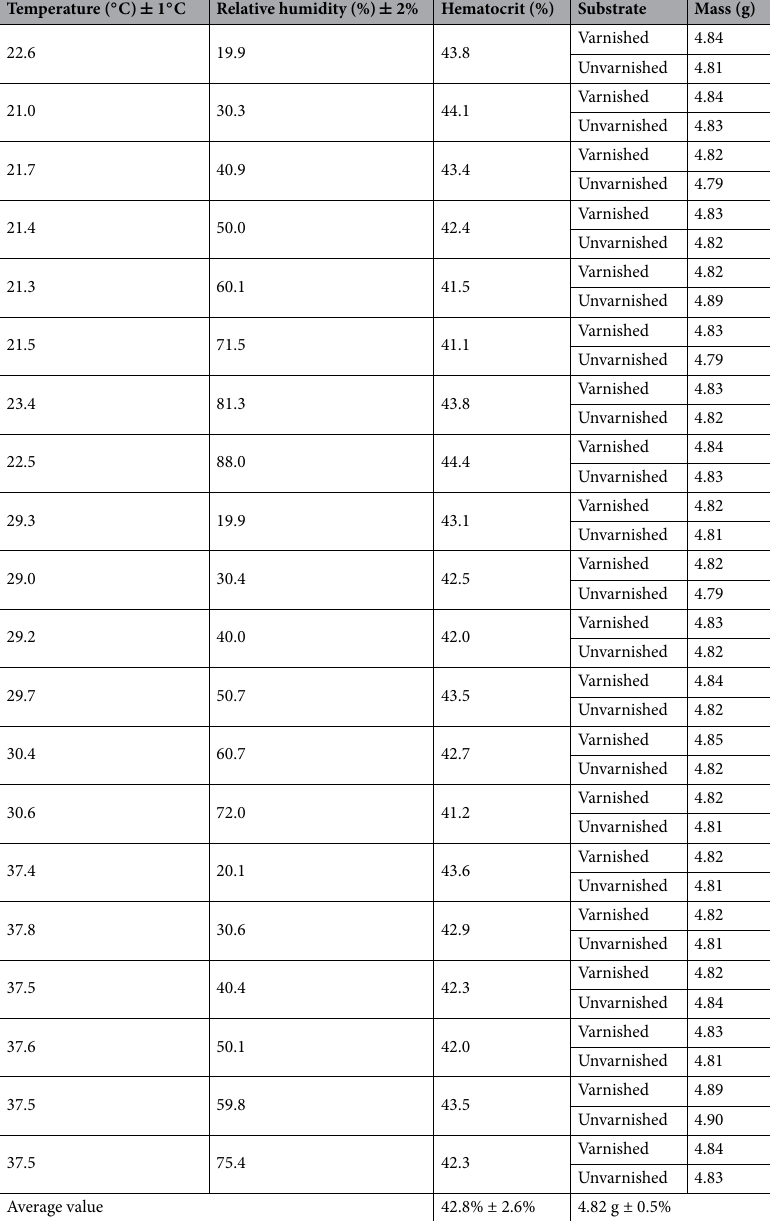
Table 1. Mass and hematocrit level of the blood samples used in this study for each surrounding